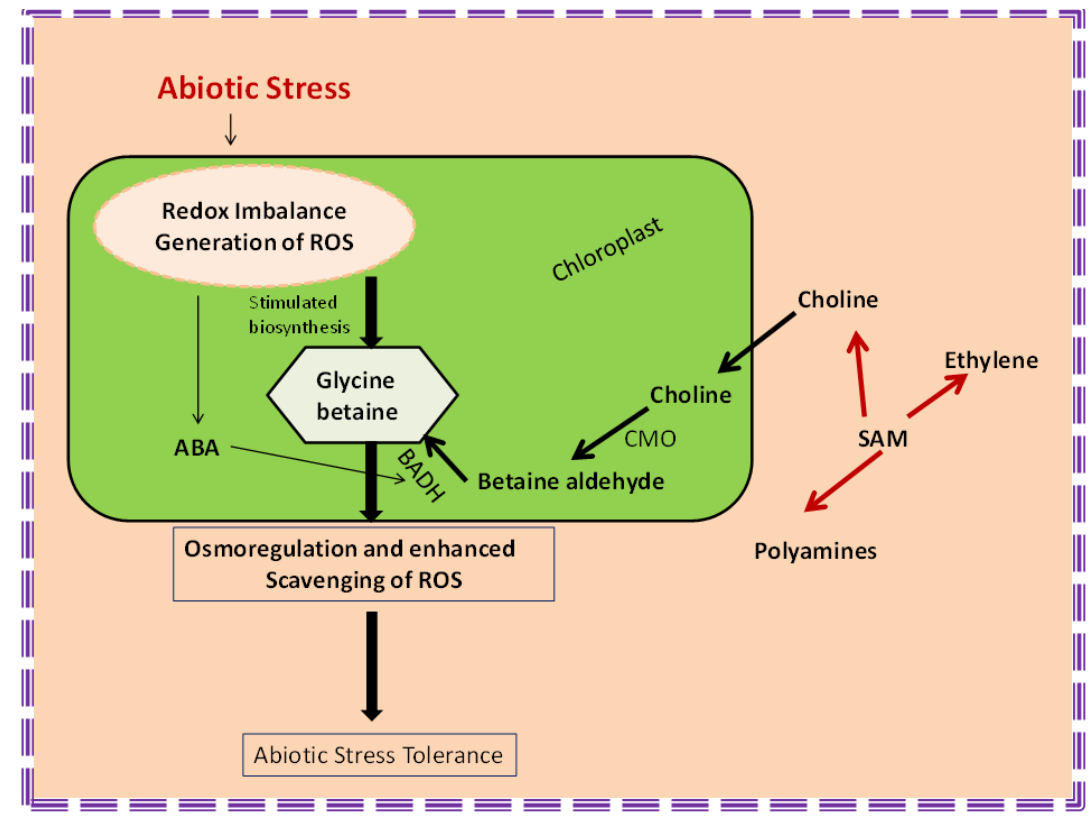
Figure 4. Biosynthetic pathway of GB and its role in abiotic stress tolerance (modified after Kurepin et al. [119]. BADH (betaine aldehyde dehydrogenase), CMO (choline monooxygenase), SAM (S-adenosylmethionine).